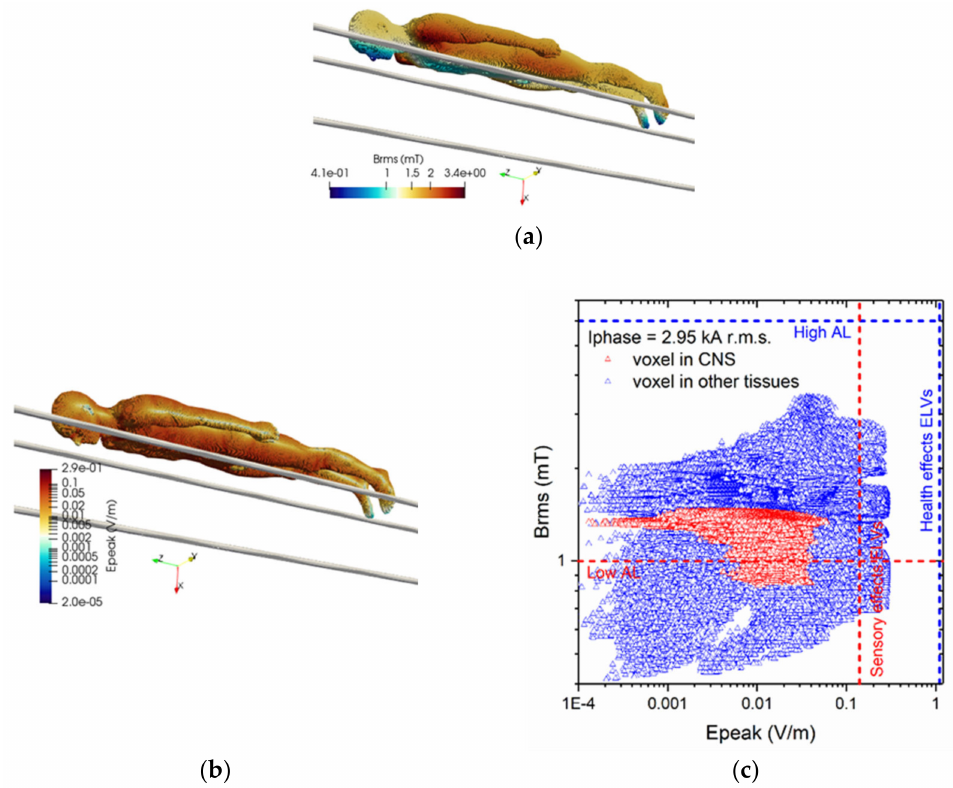
Figure 9. Results for posture A.4. On the upper left ( a ) the spatial distribution of the B-field amplitude (r.m.s. values in millitesla) over the body surface. On the lower left ( b ) the corresponding spatial distribution of the E-field amplitude (peak values in volt per metre) over the body surface. On the right ( c ) the distribution of the voxel